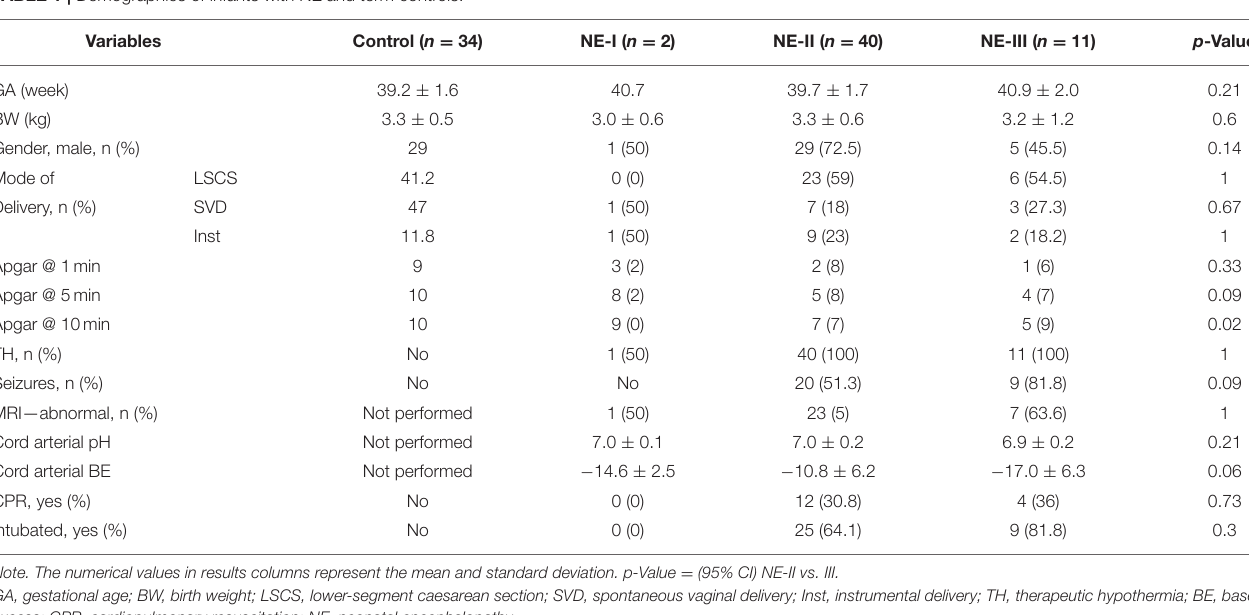
TABLE 1 | Demographics of infants with NE and term controls.